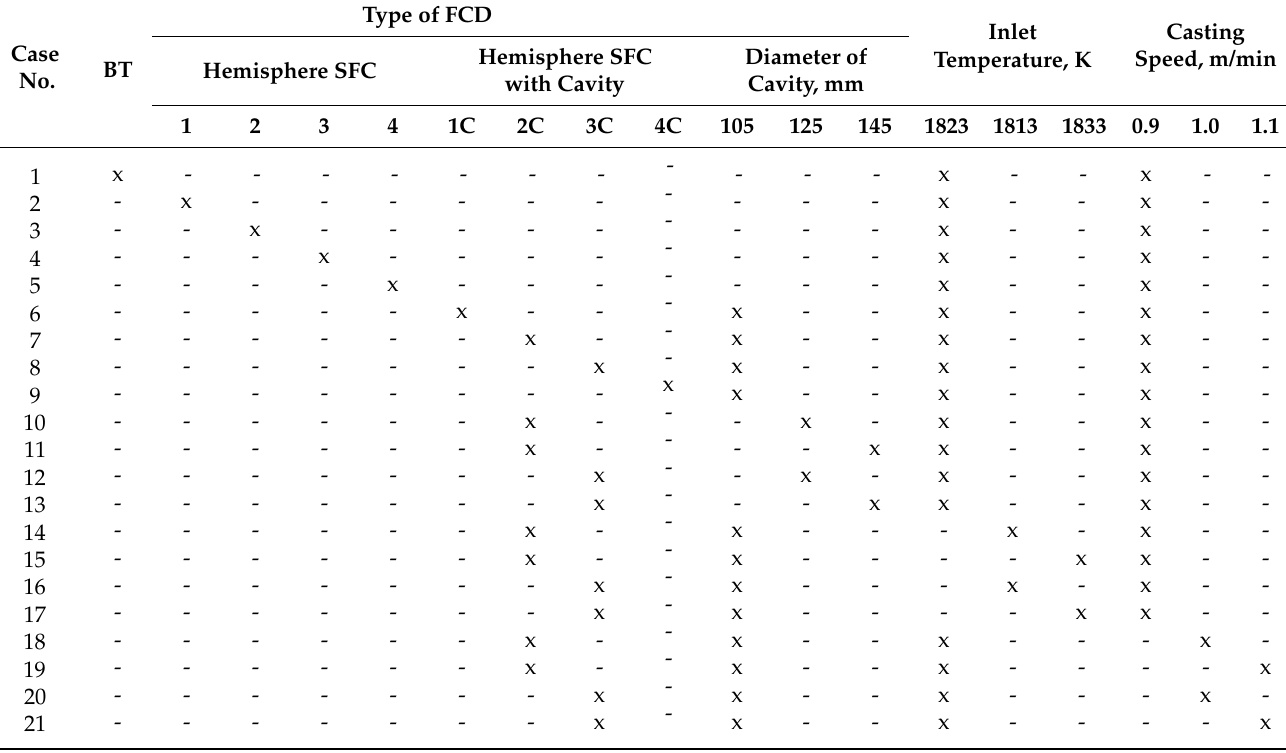
Table 1. Considered variants of tundish equipment and casting